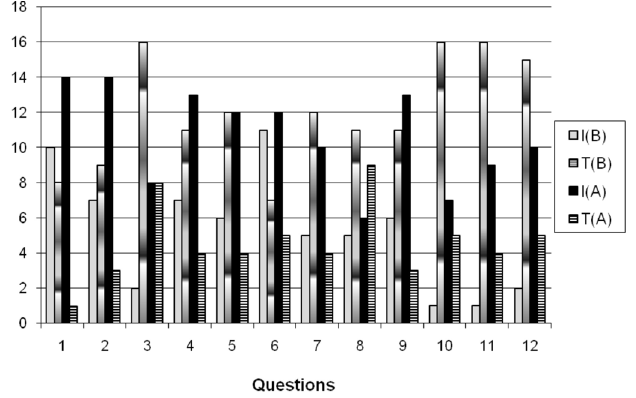
FIGURE 1 - Distribution of answers in Groups A and B. The horizontal axis represents the questions, and the vertical axis, the entries. Legend: I(A) and T(A) indicate innovative and traditional entries of Group A, respectively; I(B) and T(B) innovative and traditional entries of Group B,